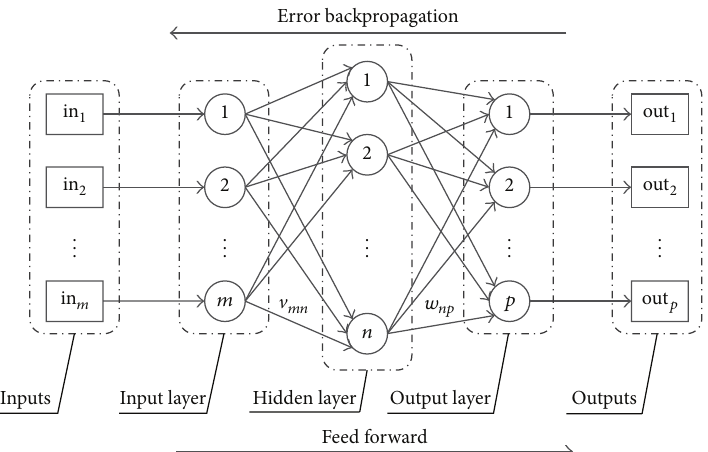
Figure 2: Scheme of Artificial Neural Network with